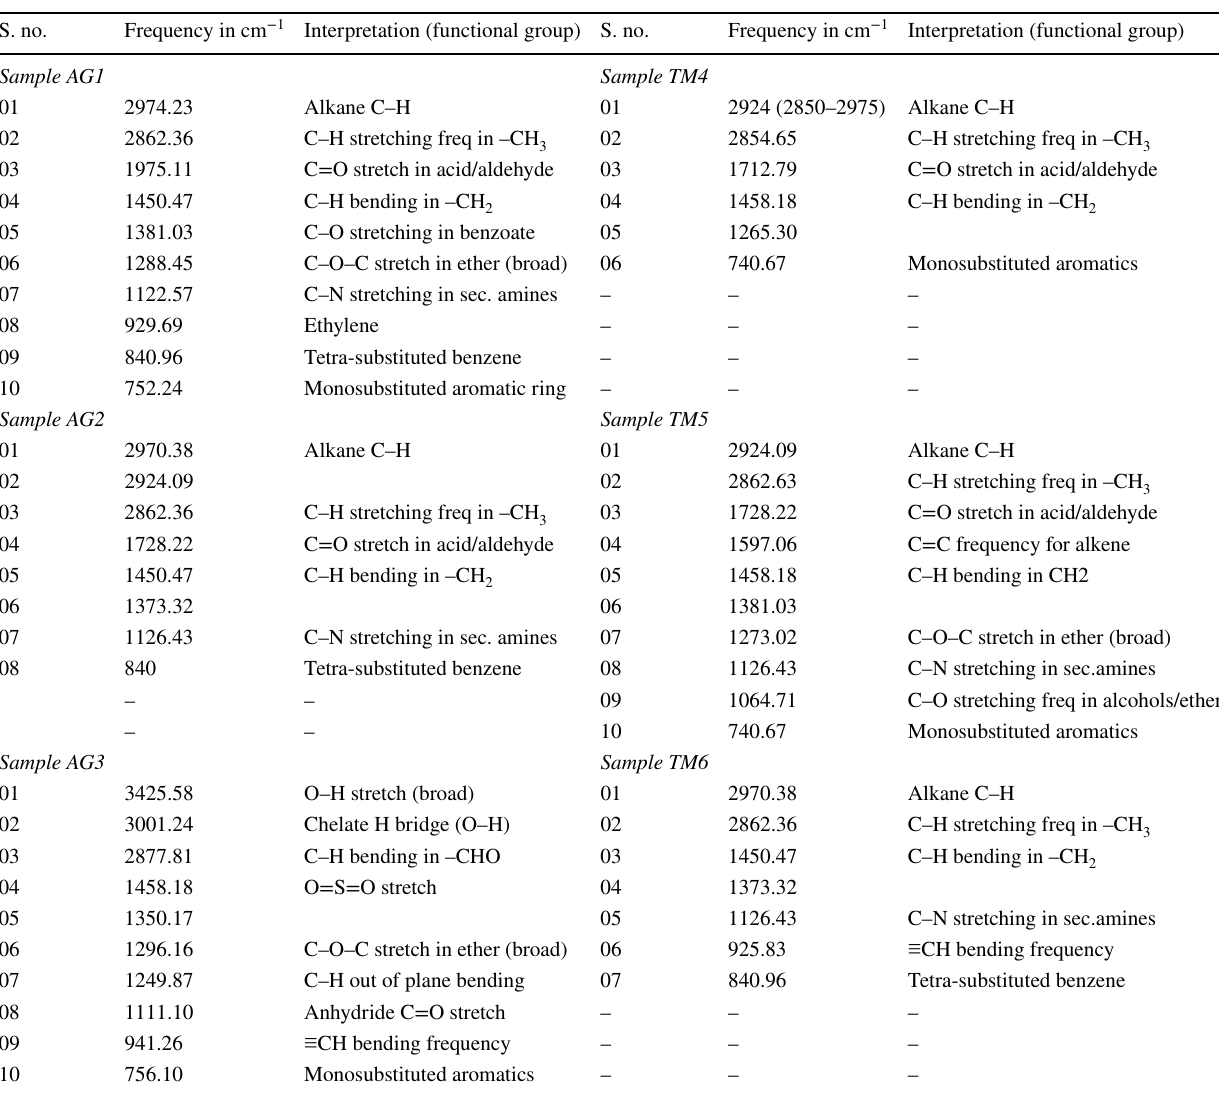
Table 2 Detected organic functional groups in collected wastewater sample S. no. Frequency in cm −1 Interpretation (functional group) S.